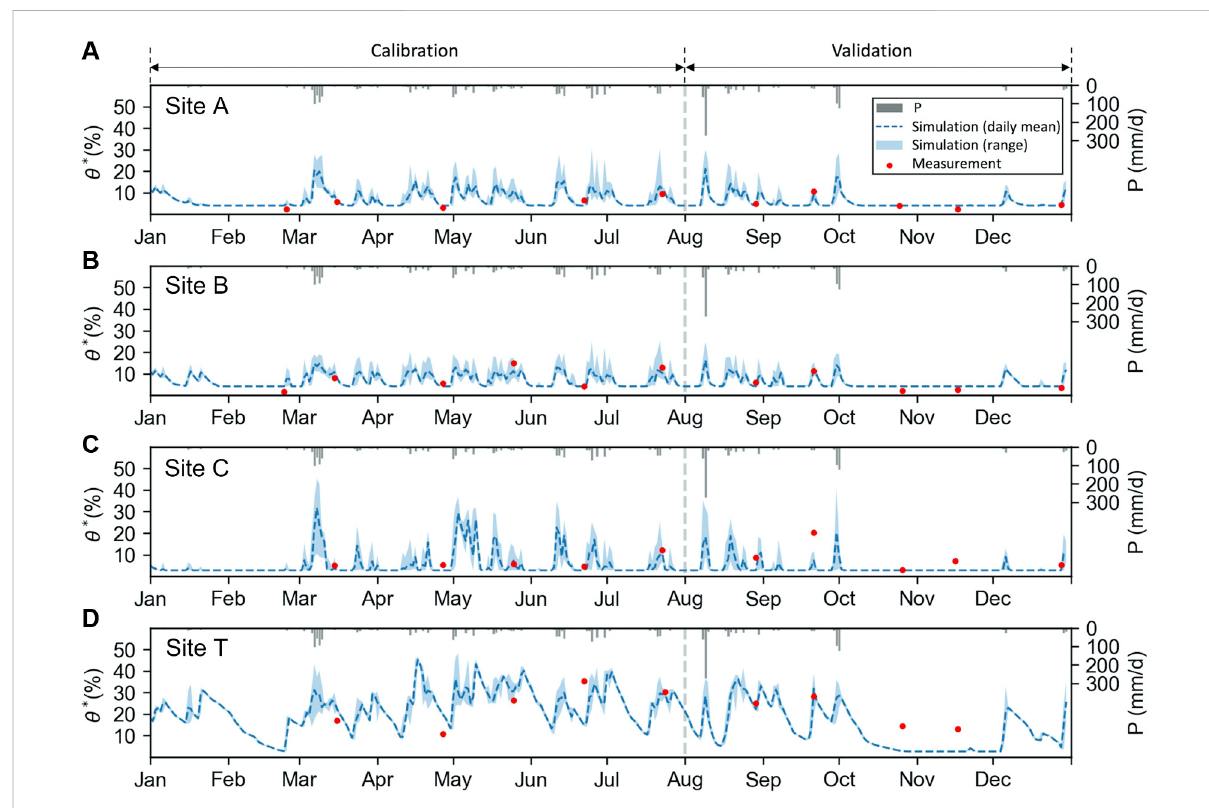
FIGURE 3 The in-situ measurementsandthesimulationresultsofthevolumetricsoilwatercontent( θ * )at (A) siteA, (B) siteB, (C) siteC,and (D) siteTinthe Yufeng